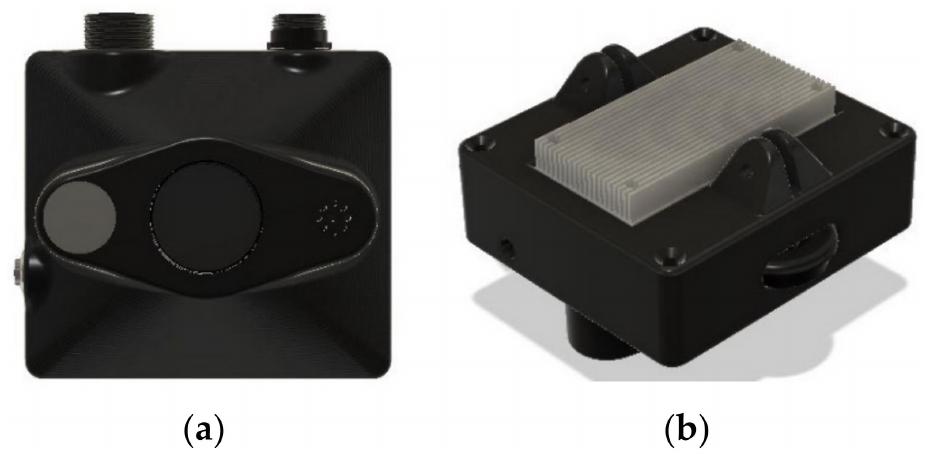
Figure 10. Future Camera Trap. ( a ) Front view. ( b ) Top